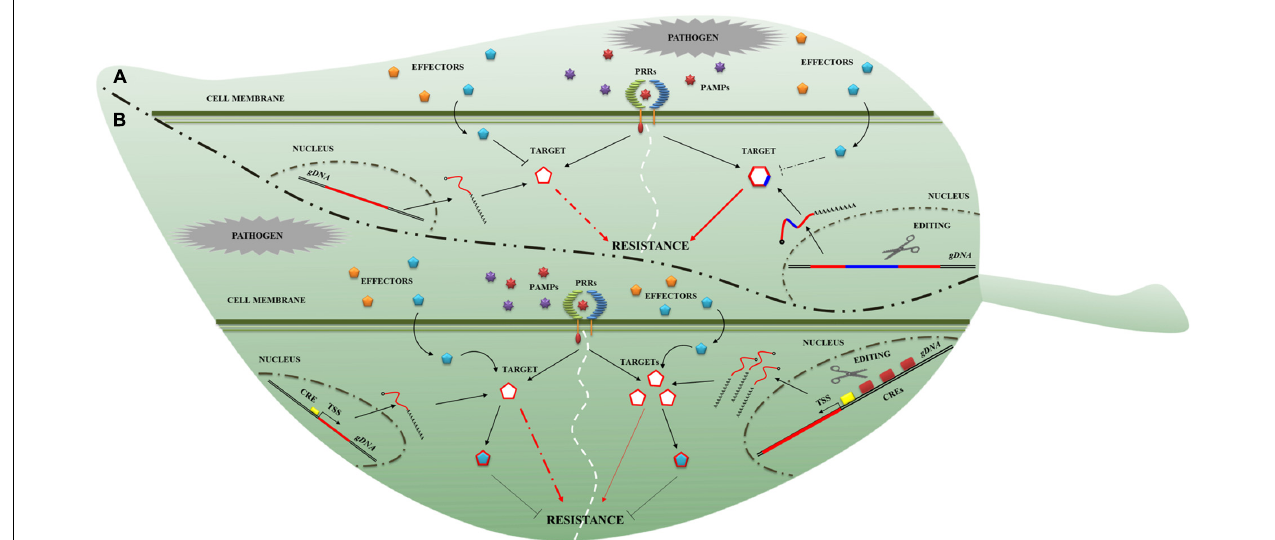
FIGURE 2 | Novel genome editing targets for plant disease resistance breeding. Two genome editing applications (A,B) to obtain resistance plant are presented. (A) In the first example, the modification (blue line) of the effector-target to restore resistance is proposed. The target gene sequence (red line on the left side) is modified (red-blue line on the right side) to impede the effector- (cyan pentagon) target (red-blue hexagon) interaction. (B) The second example describes the possibility of modifying the effector-target promoter. In particular, it is depicted a cis-acting regulatory element (CRE; yellow rectangle on the left side) that controls the gene-expression of effector-target (curve red line) and product release (cyan pentagon). On the right, the increase of CREs (red rectangles on the right side) enhances the effector-target expression (curve red lines) and product release (cyan pentagons) conferring a partial resistance (thin red arrows). The dashed red arrows in (A,B) panels and dashed black line in (A) indicate an interrupted connection between components involved in the resistance